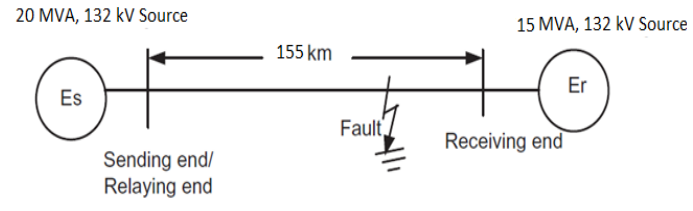
Table 2. Substation parameters.